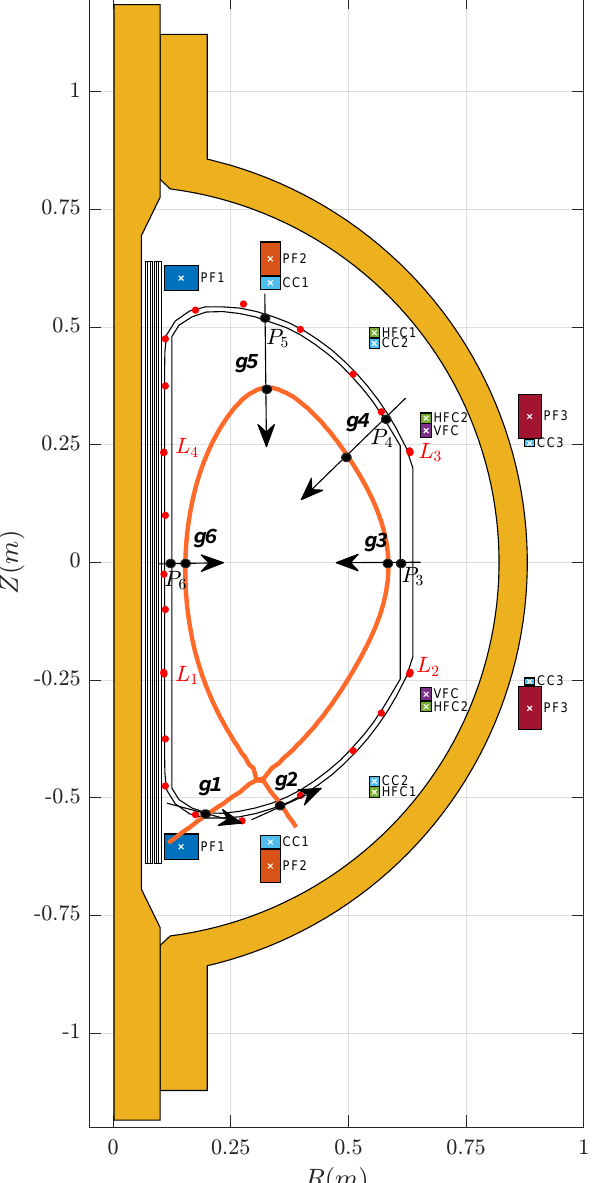
Figure 4. Poloidal system of the Globus-M2 tokamak and plasma boundary with strike points g 1, g 2 and gaps g 3– g